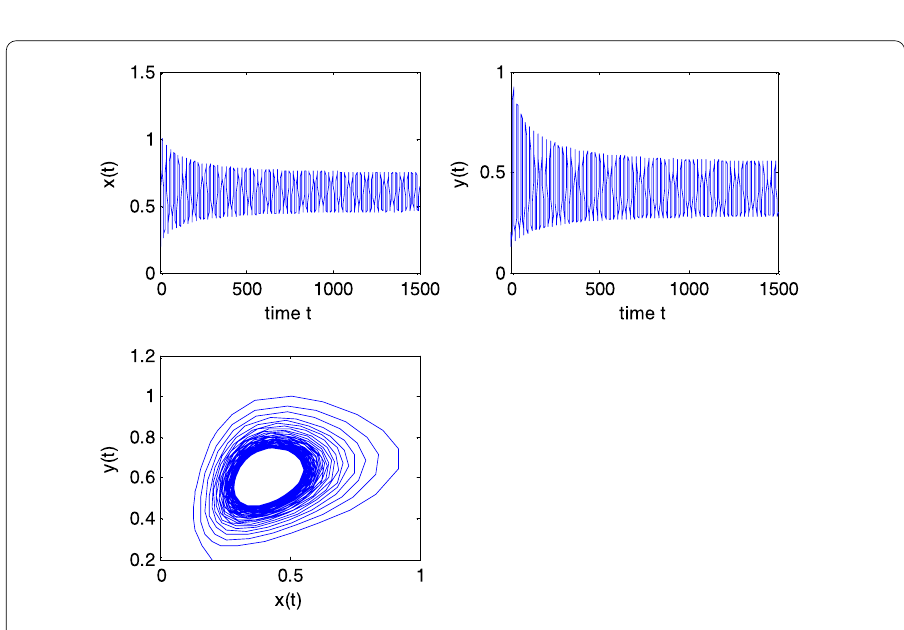
Figure 6 Behavior and phase portrait of a controlled system (1.3) with τ 1 = 2.8 > τ 10 , τ 2 = 3.0. Hopf bifurcation occurs from the positive equilibrium E ∗ ( x ∗ , y ∗ ) = ( 2